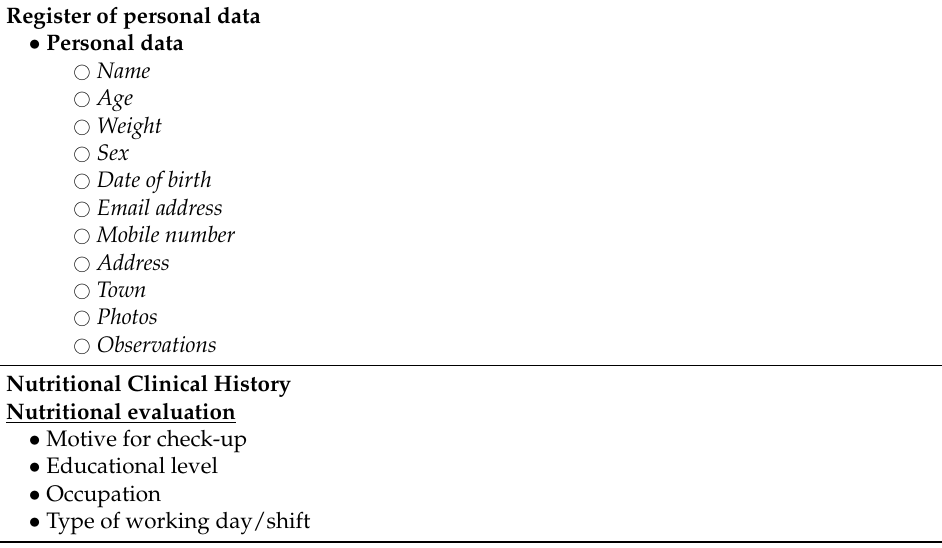
Table A1. Variables Analyzed by the Different Nutritional